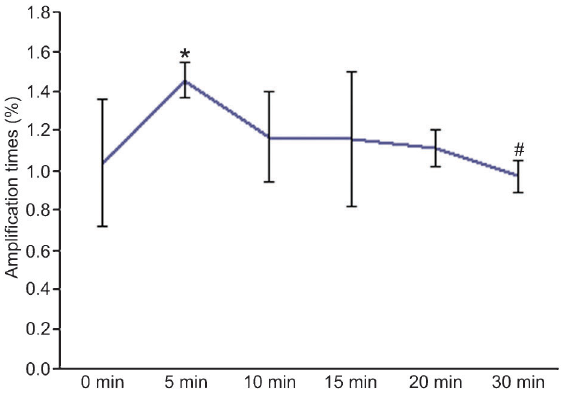
Figure 2. Changes of lipopolysaccharide-induced M 3 receptor activation with time in human pulmonary microvascular endothe- lial cells (n=3). M 3 receptor had the highest expression at 5 min, then attenuated gradually from 10 to 30 min. *P , 0.05, compared with 0 min; # P , 0.05, compared with 5 min